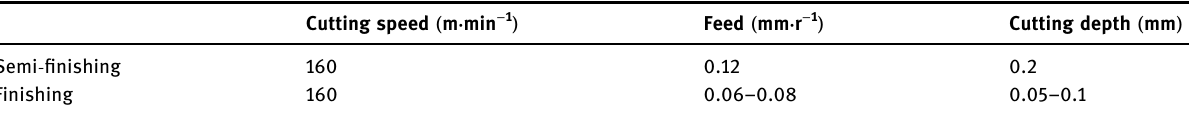
Table 2: Turning